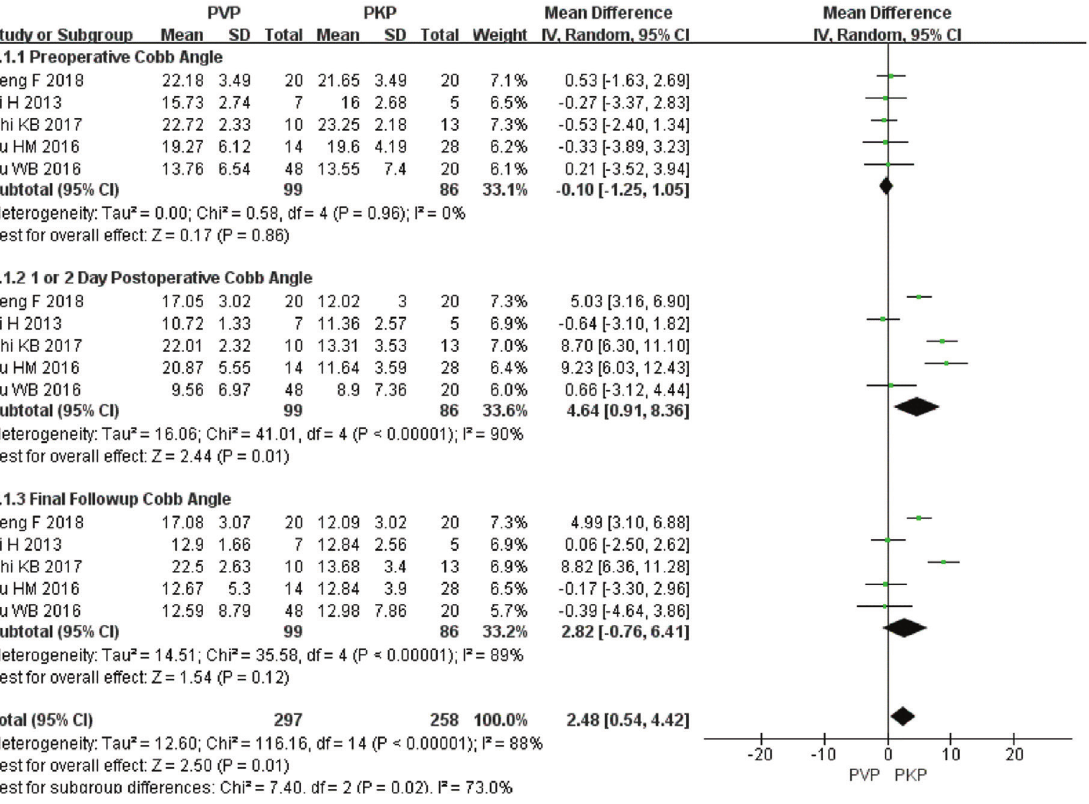
Table 1. General characteristics of included